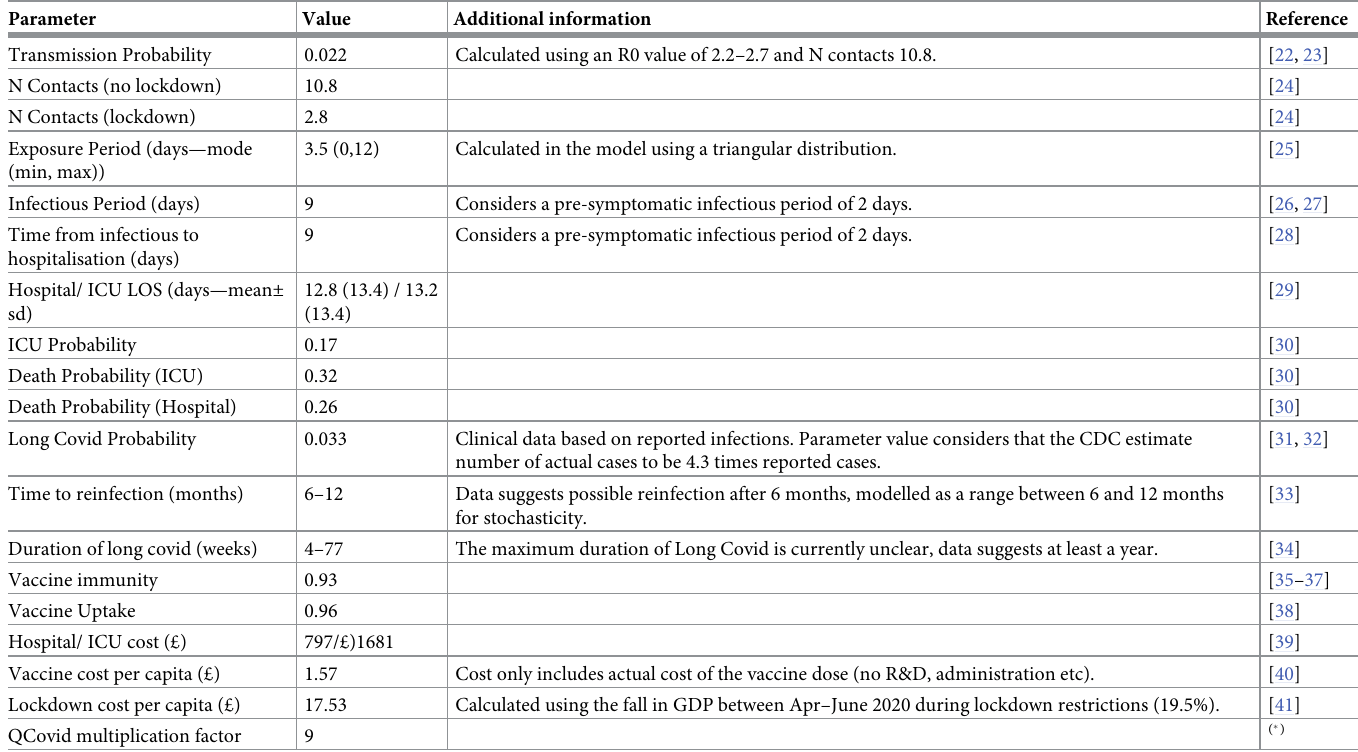
Table 2. CALMS input parameter names and values, sources and additional